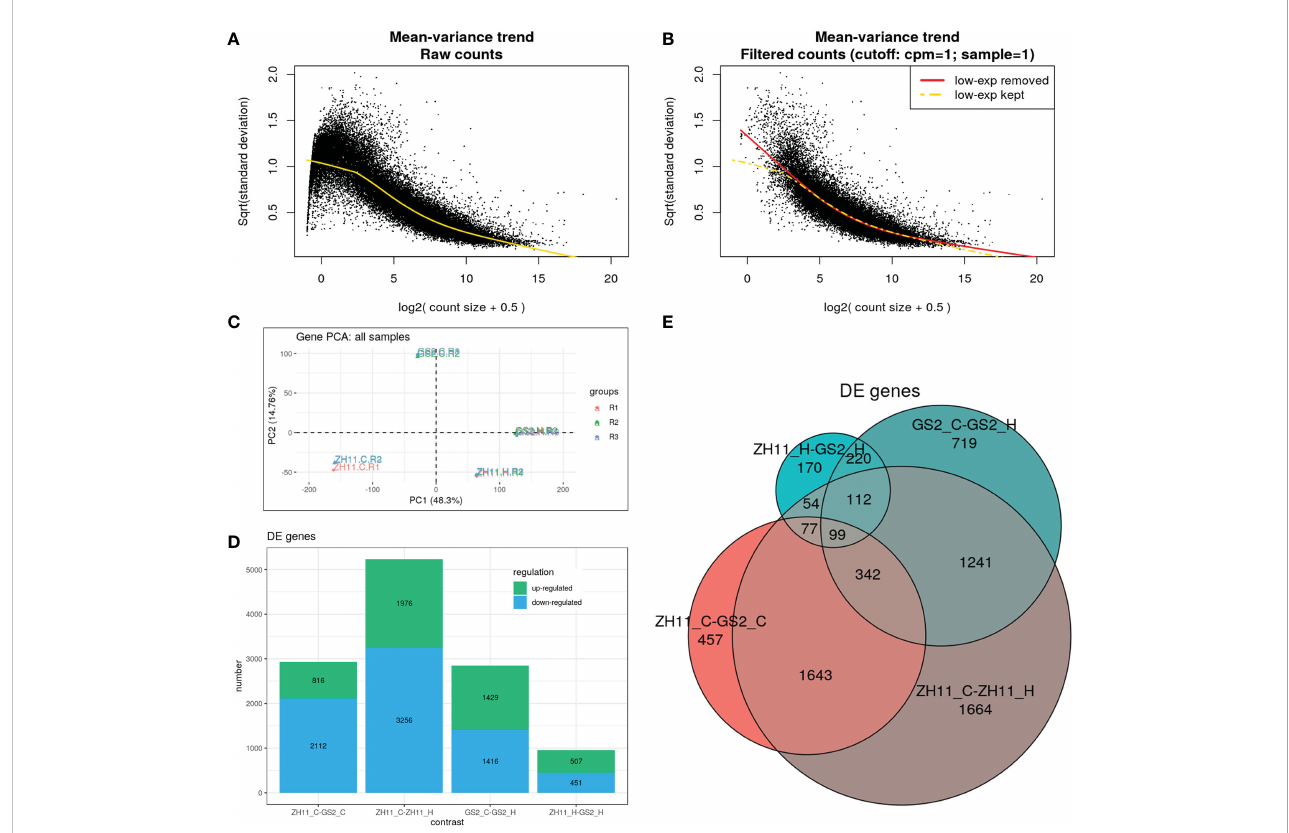
FIGURE 2 Gene expression patterns in Zhonghua 11 (ZH11) and grain size on chromosome 2 (GS2) under different temperature conditions. (A) Mean – variance trend of raw read counts (before fi ltering). (B) Mean – variance trend of fi ltered read counts (poorly expressed reads removed). (C) Principal component analysis (PCA) plots of 12 libraries. (D) Differentially expressed gene (DEG) numbers of four separate comparisons. The green box shows up-regulated genes and the blue box shows down-regulated genes. (E) Speci fi c and overlapping DEG numbers across four different